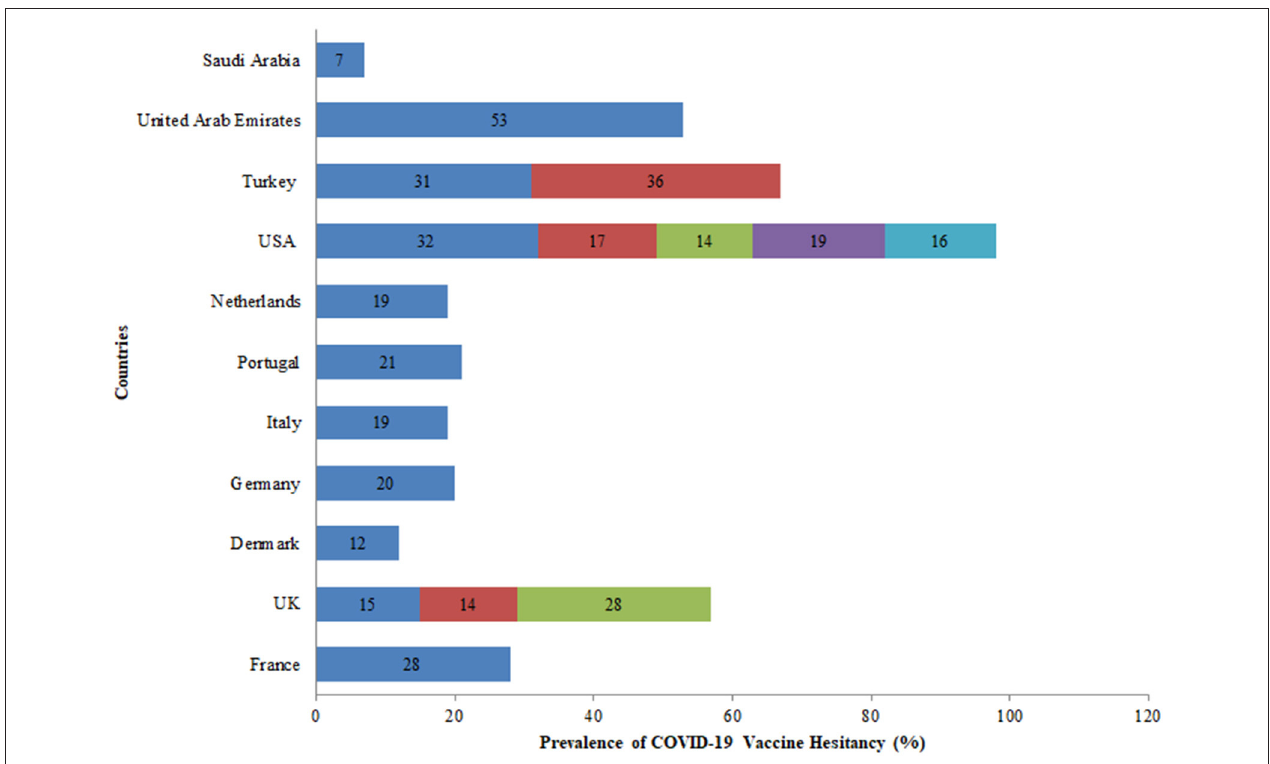
FIGURE 7 | Prevalence of COVID-19 vaccine hesitancy worldwide among the general population.